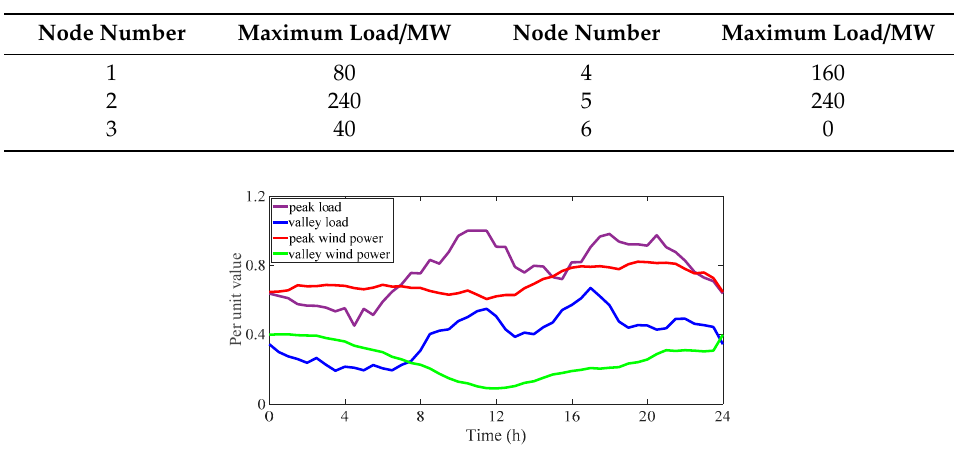
Table A3. Garver-6 system maximum node load.